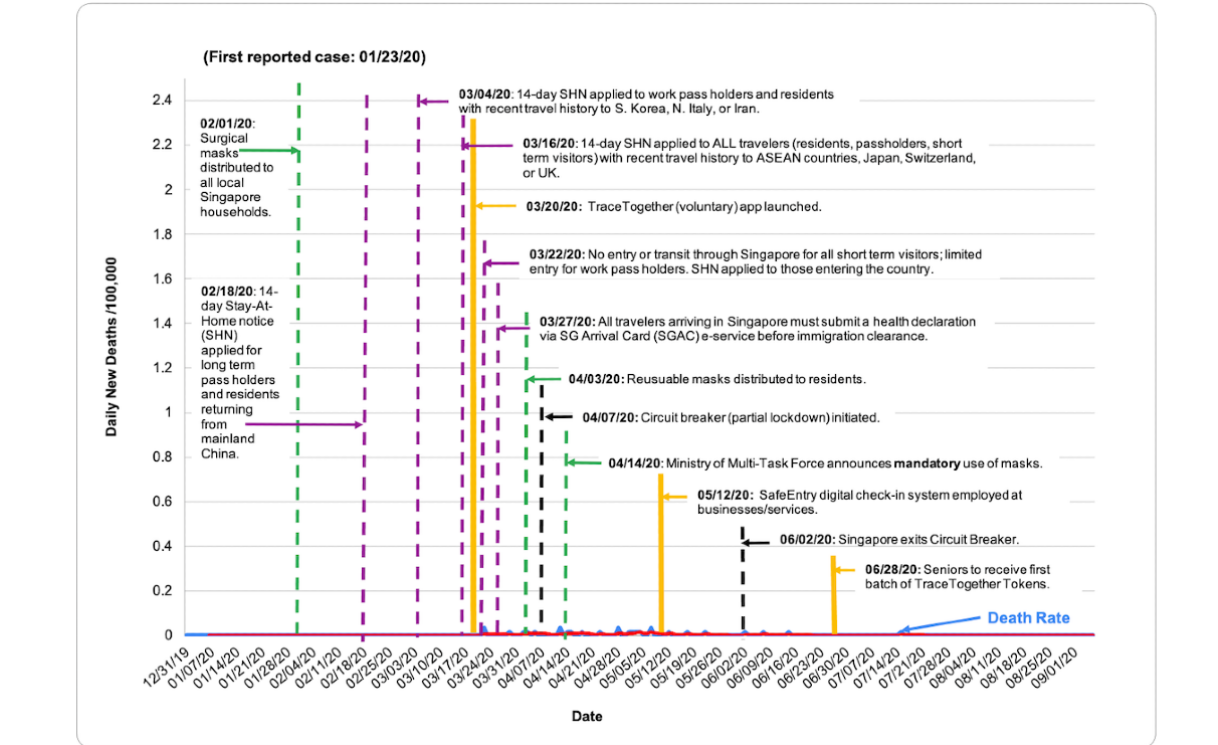
Figure 4. Daily new deaths per 100,000 people for Singapore from December 31, 2019, to September 6, 2020. ASEAN: Association of Southeast Asian Nations; SHN: Stay-Home Notice.